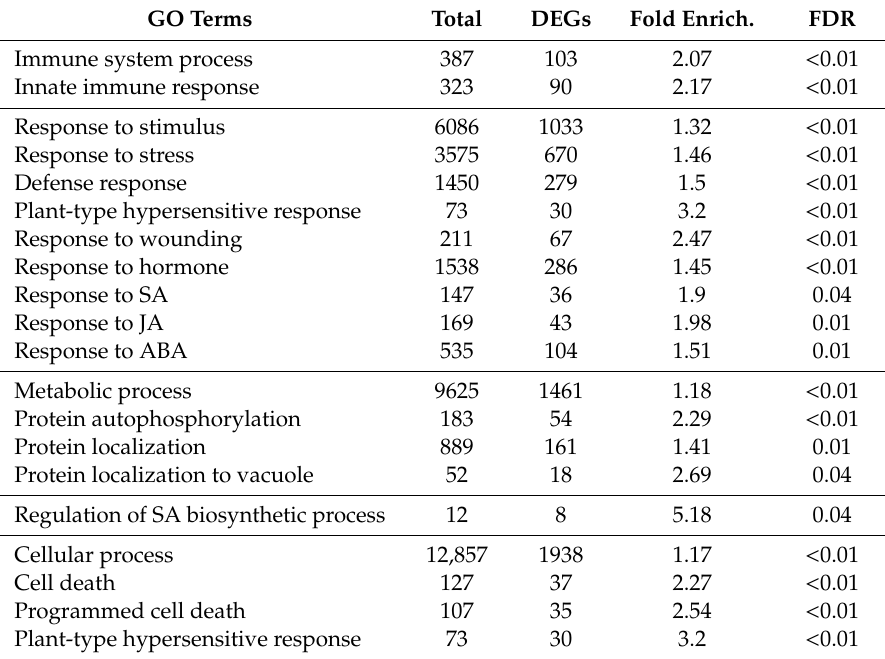
Table 1. Selected gene ontology (GO) terms (biological process) for up-regulated genes in the i-amiCHLI transgenic line after Dex